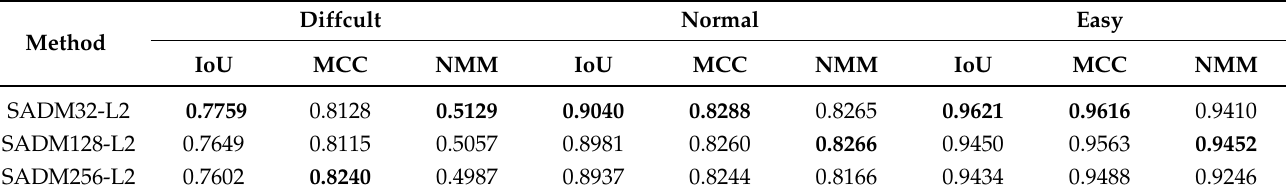
Table 1. Truncation error of SADM.